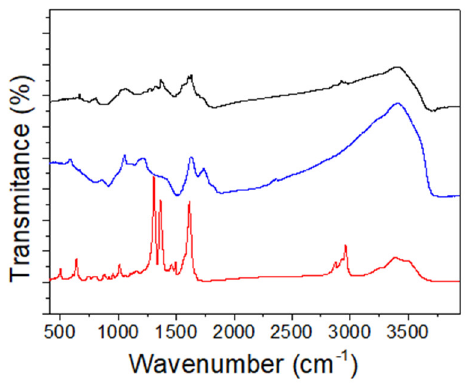
Figure 4. Fourier transform infrared (FTIR) spectra of (TBA) 2 Mo 6 I i8 @GO (back line), GO (blue line) and (TBA) 2 [Mo 6 I i8 (O 2 CCH 3 ) a6 ] (red